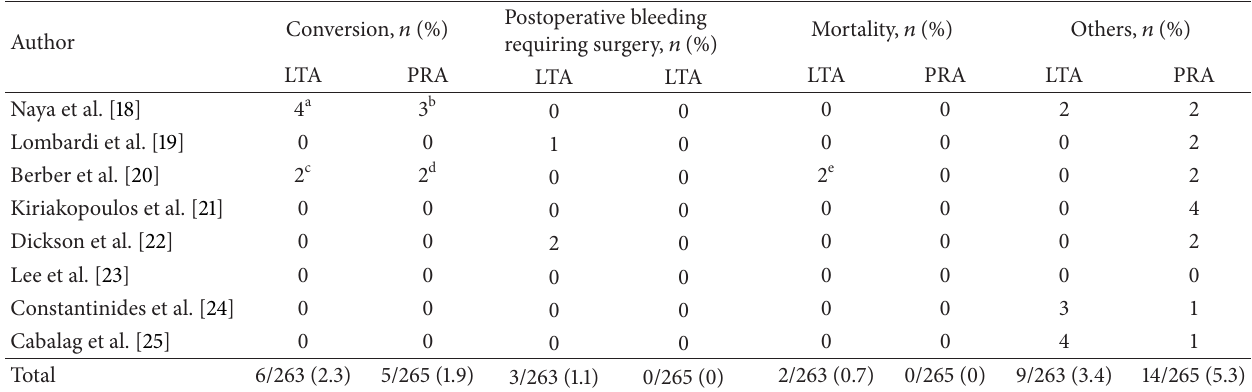
Table 3: Complications of laparoscopic LTA versus